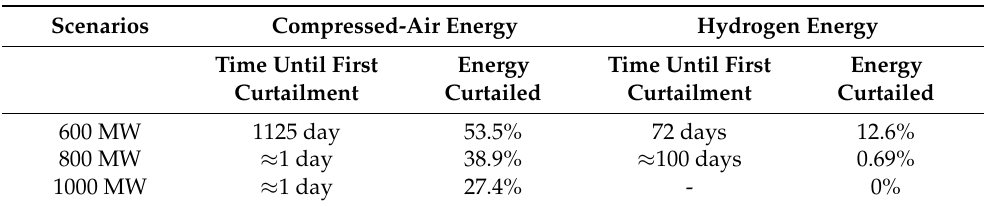
Table 2. Seasonal load-shifting comparison between compressed-air energy storage and compressed- hydrogen energy storage systems